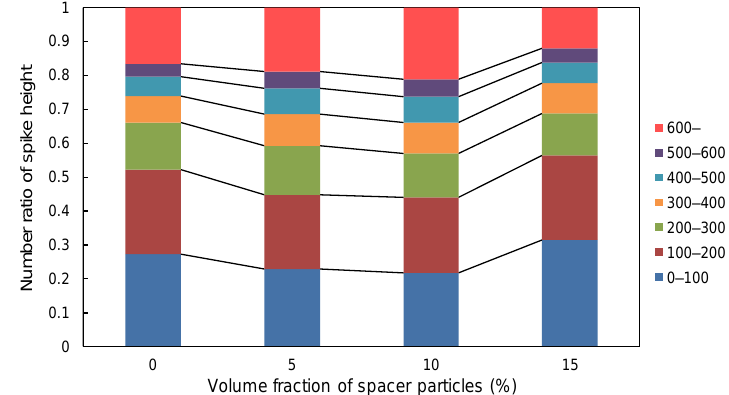
Figure 8. Ratio of the number of spectral spikes in different height ranges. The volume fraction of scattering particles is 10%. The pumping energy and energy density are 13 µJ and 22.8 µJ/mm 2 , respectively.